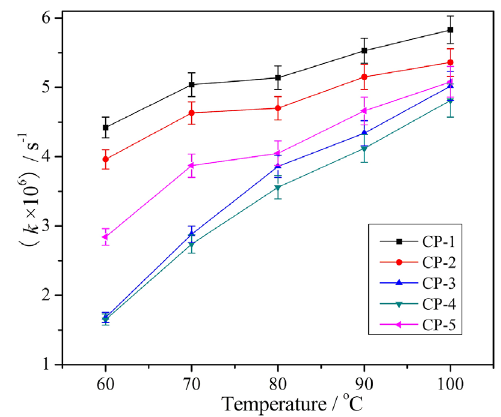
Figure 3. Curves of reaction rate constant vs.